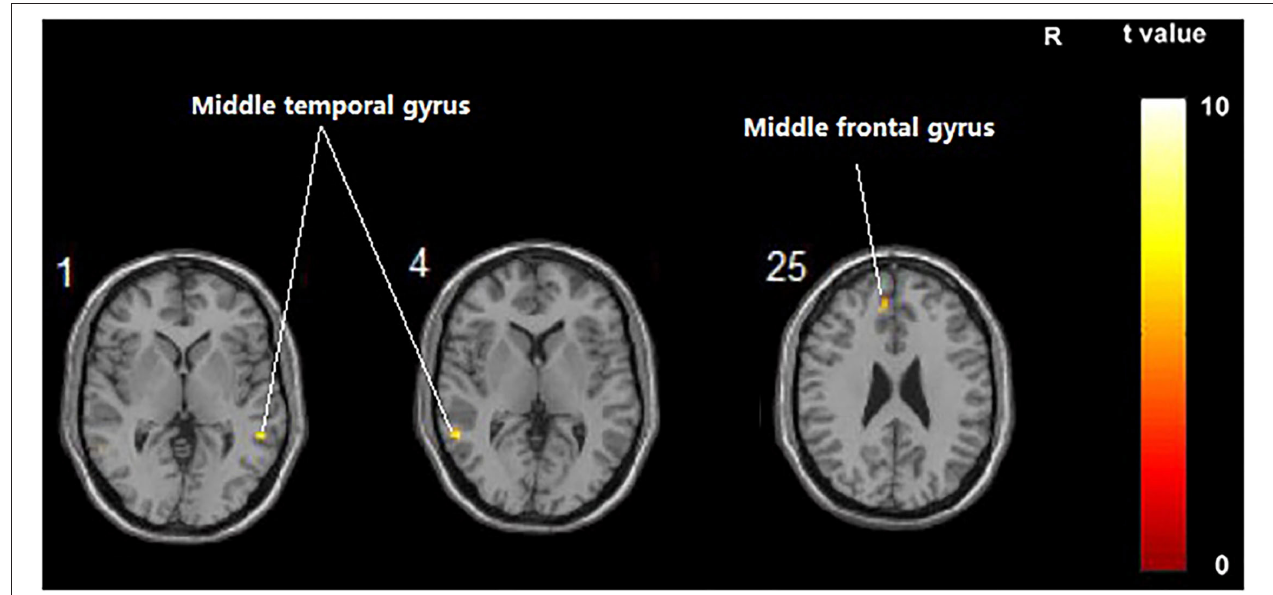
FIGURE 5 | Regions showing significant FC changes between the treatment group and control group. The results were uncorrected with 5 < 0.001.